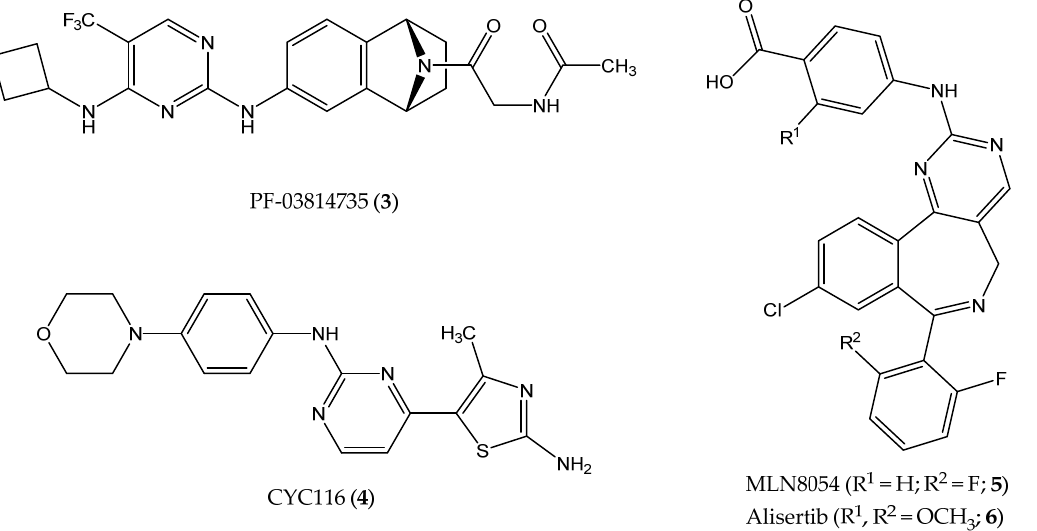
Figure 2. Aurora kinase inhibitors displaying 2-anilinopyrimidine partial structures [14].